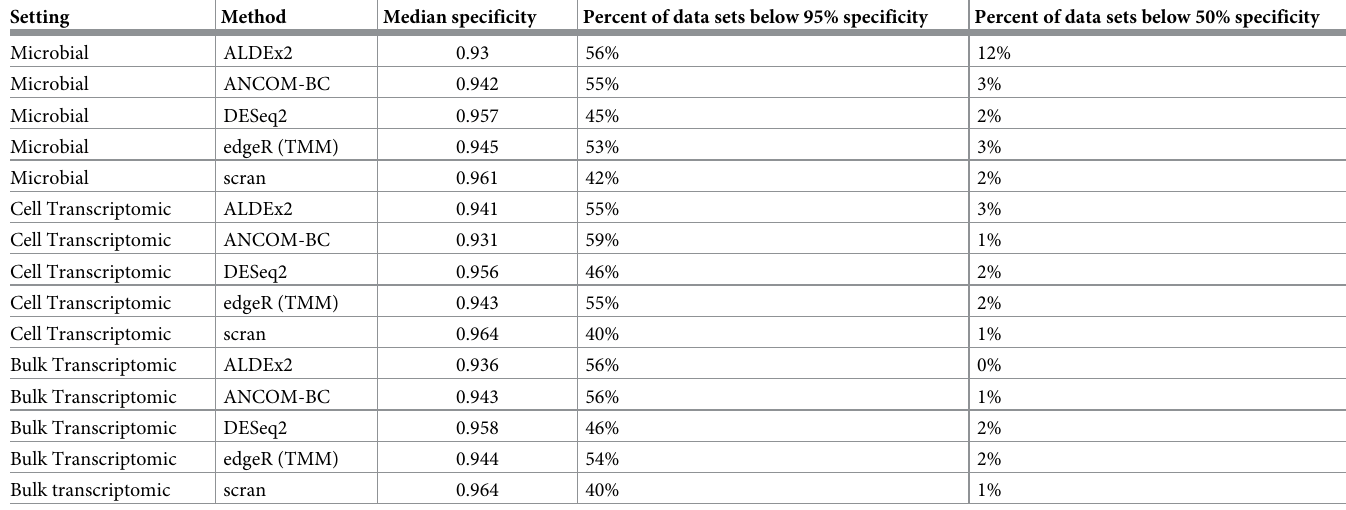
Table 2. Median and thresholded specificity by simulated setting, FDR � 0.01 plus effect size thresholding. Specificity in simulated data under more stringent condi- tions: here differential abundant is called using FDR � 0.01 and an effect size threshold (a fold change of at least 2-fold).